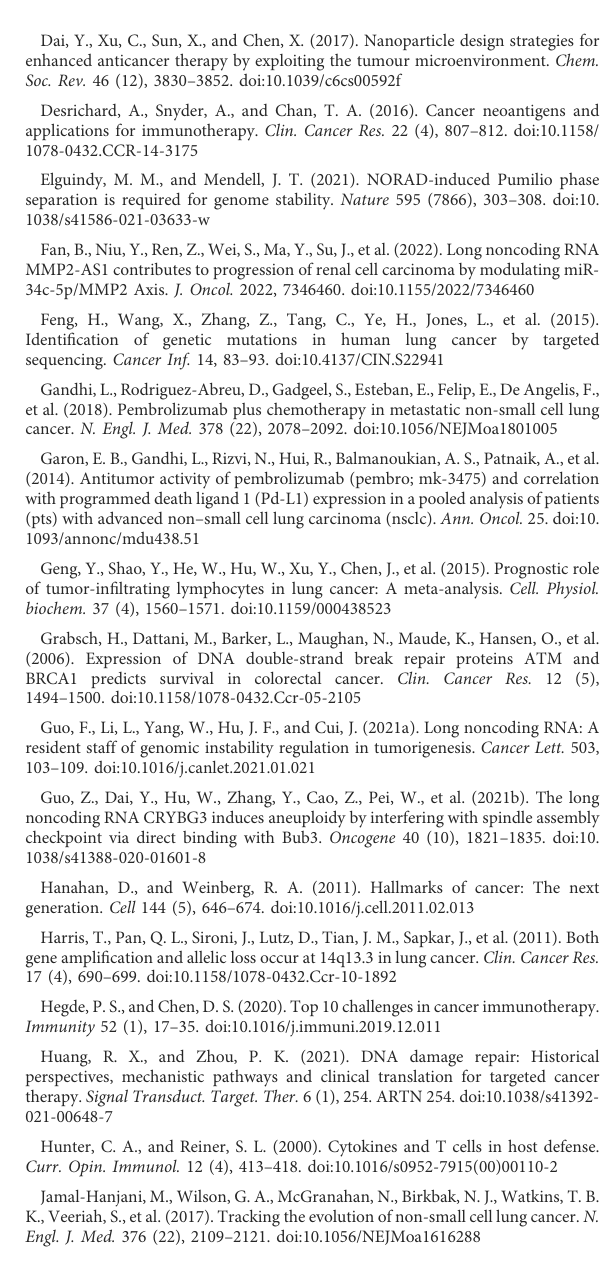
Forest plot of 34 lncRNAs associated with prognosis in the train set. Red dots represent risky lncRNAs, while blue dots represent protective lncRNAs. The black bar represents the 95% CI of the hazard ratio. CI, con fi dence